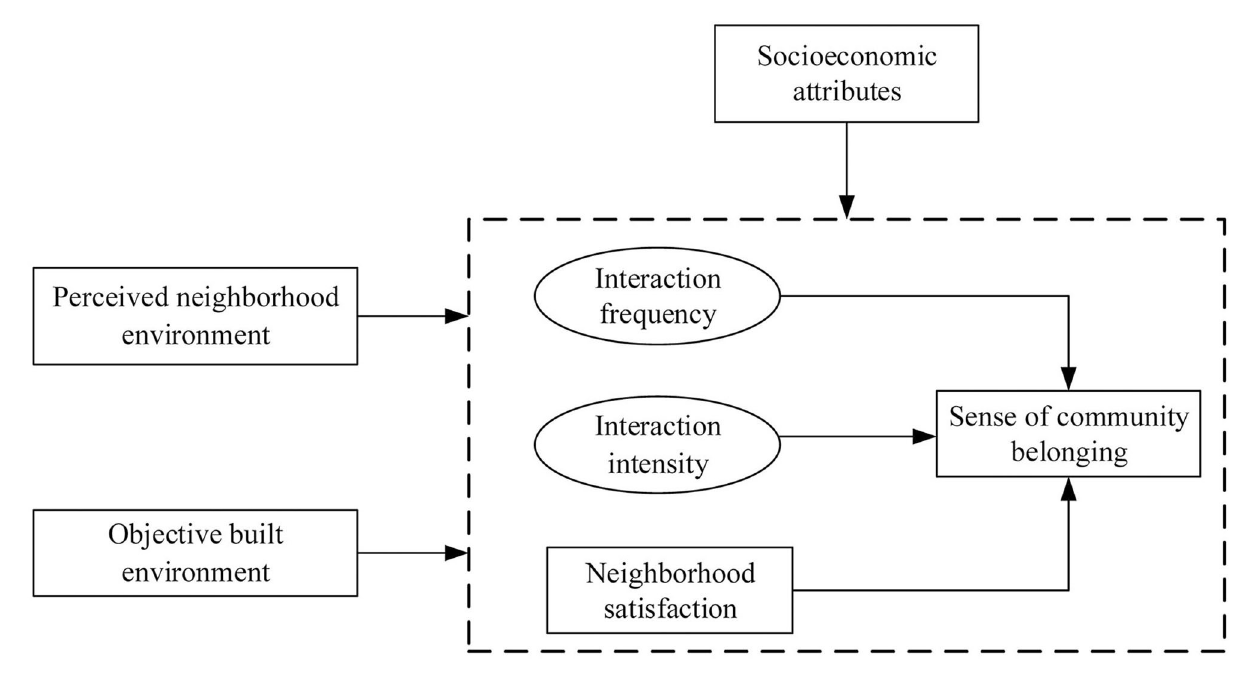
FIGURE2 Conceptual